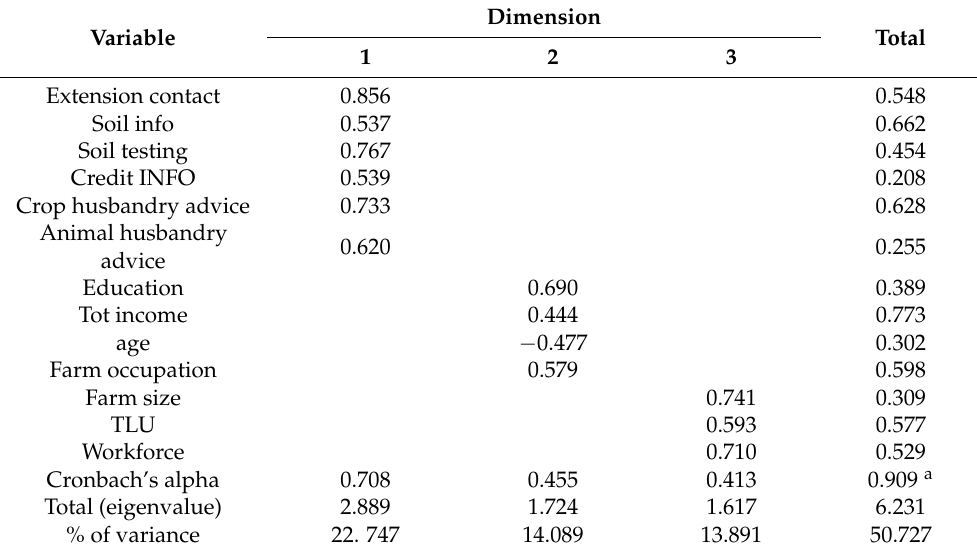
Table 5. Principal component loadings of household socio-economic variables based on CATPCA analysis using variable principal